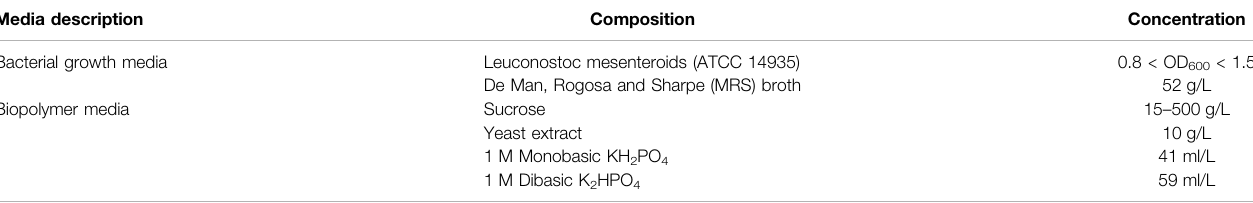
TABLE 1 | Media for the growth of bacteria and biopolymer production.